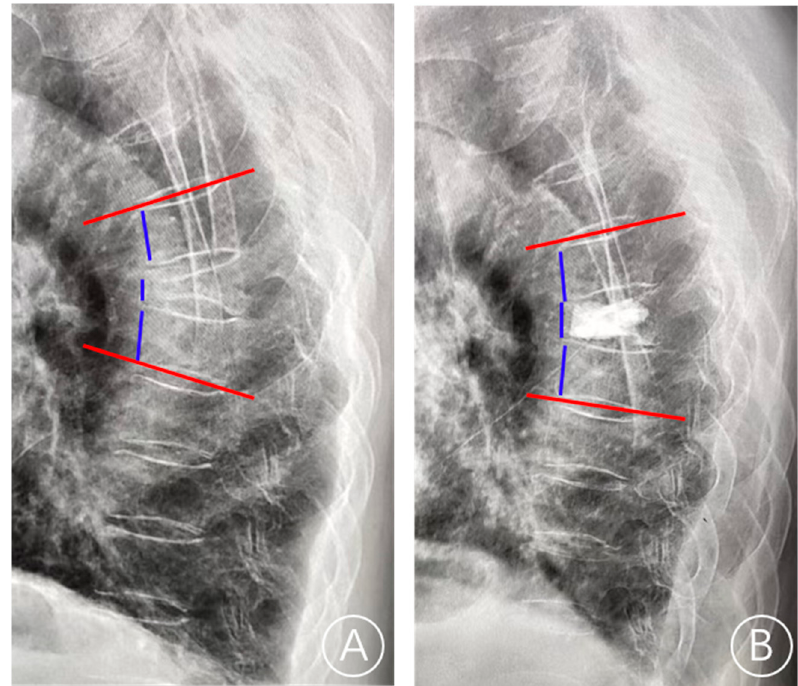
Figure 3. The lateral radiograph showed the measurement of the anterior vertebral height and the local Cobb angle. ( A ) On the preoperative lateral radiographs, the anterior height of the fractured vertebra, the upper adjacent vertebral anterior height, the lower adjacent vertebral anterior height, and the Cobb angle were measured. ( B ) On the postoperative lateral radiographs, the anterior height of the fractured vertebra, the upper adjacent vertebral anterior height, the lower adjacent vertebral anterior height, and the Cobb angle were measured. The red line is the endplate and the blue line is the anterior vertebral height.